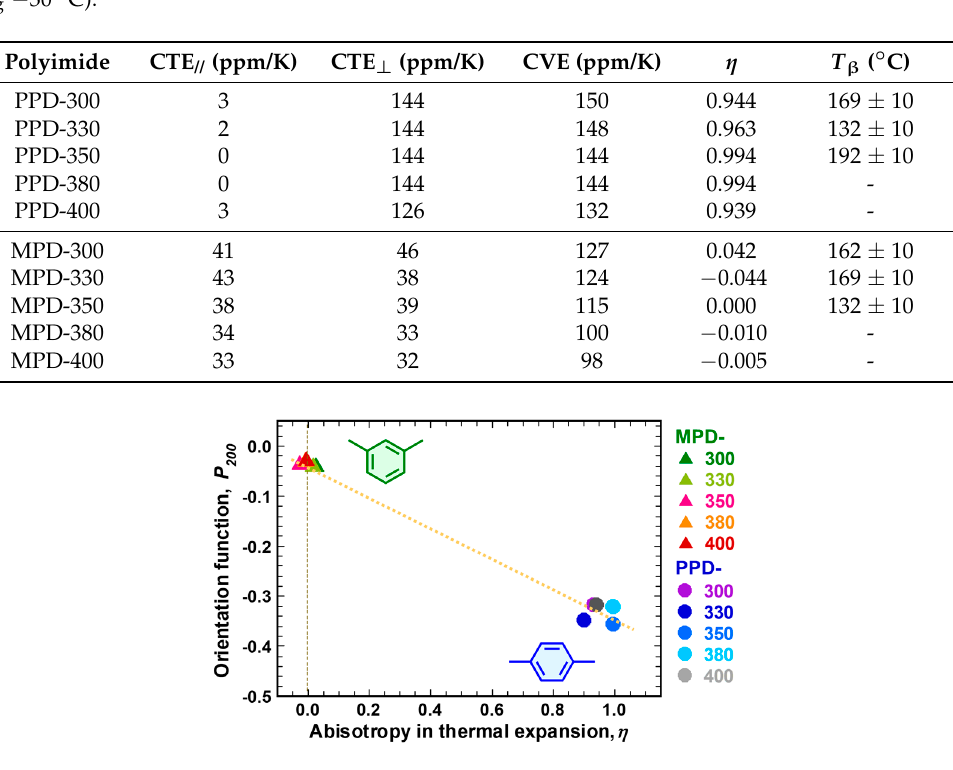
Table 4. Coefficient of thermal expansion (CTE) in the in-plane direction of the PI film (CTE // ) and in the out-of-plane direction (CTE ⊥ ), as well as the coefficient of volumetric thermal expansion (CVE), anisotropy in CTE ( η ), and β -transition temperatures determined by the dynamic mechanical analysis (DMA) curves of PI films. The CTEs were estimated in the temperature range of 80 and 280 ◦ C or ( T g − 30 ◦ C).